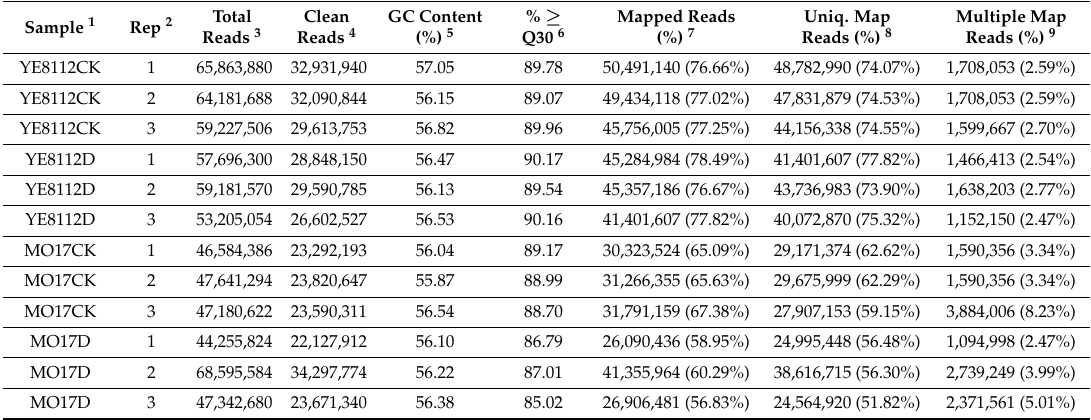
Table 2. Summary of RNA sequencing results for the twelve maize seedling leaf